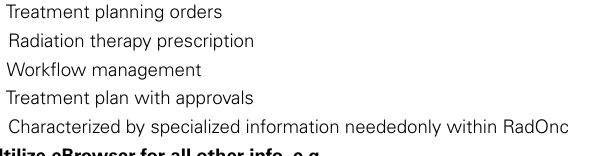
Table 5 |Virtual radOnc chart:ARIA + eBrowser. UtilizeARIA for radiation oncology-specific processes, e.g.